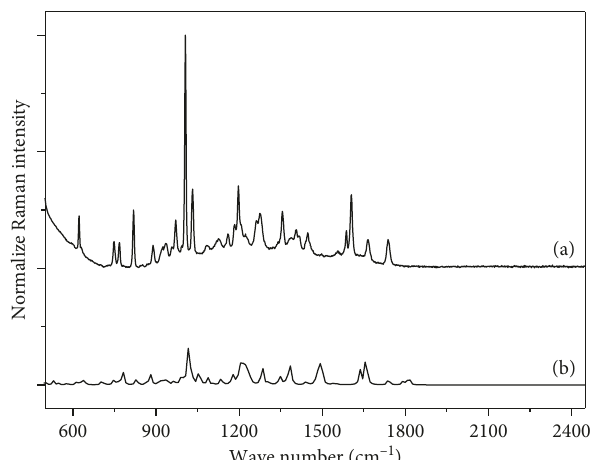
Figure 3: Comparing the Raman spectrum calculated by the as- partame gauss with the experimental data. (a) Experimental result and (b) computational results. Aspartame powder: laser wave- length, 532nm; power, 1.25mW; objective lens,